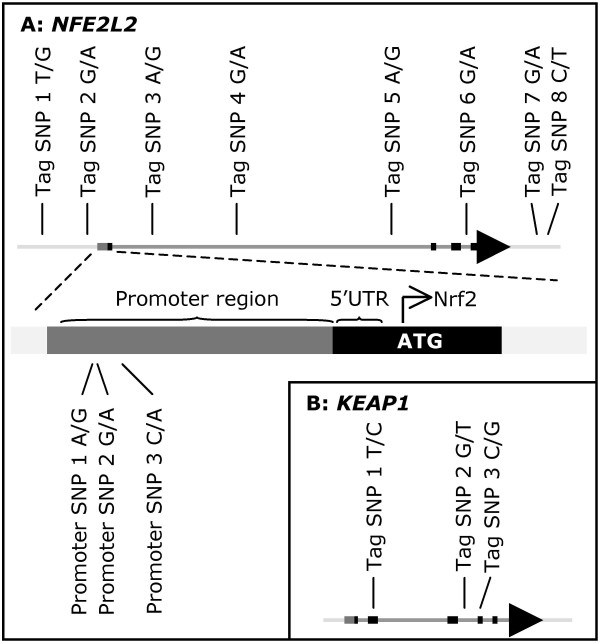
Schematic overview of the NFE2L2 (panel A) and KEAP1 (panel B) genes and the tag SNPs used in the study (for rs-numbers see table 2). Thick black lines indicate exons. The promoter region of NFE2L2 is detailed in panel A.